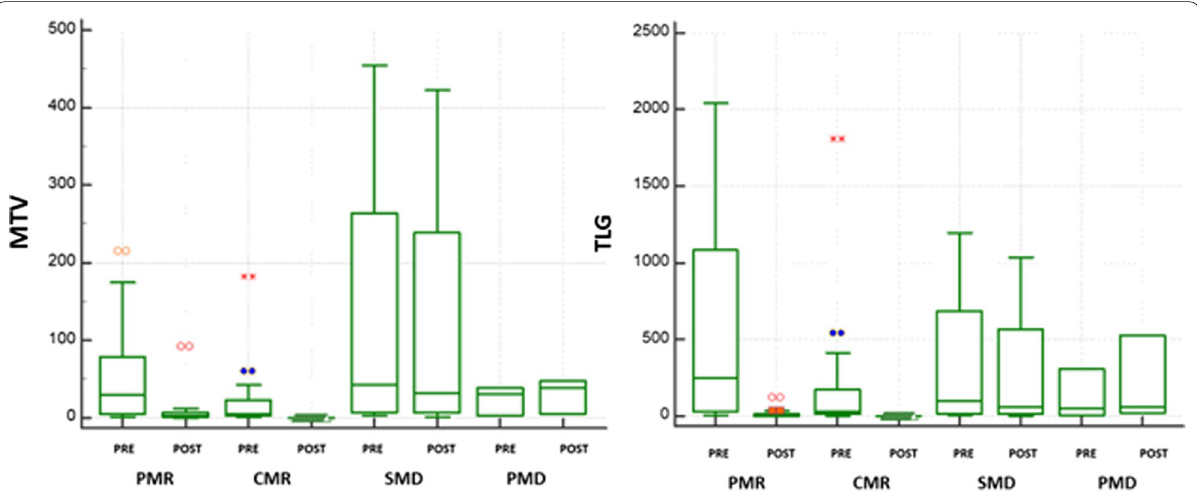
Fig. 6 Box-and-whisker plots of pre-treatment and post-treatment MTV and TLG in PMR, CMR, SMD, and PMD